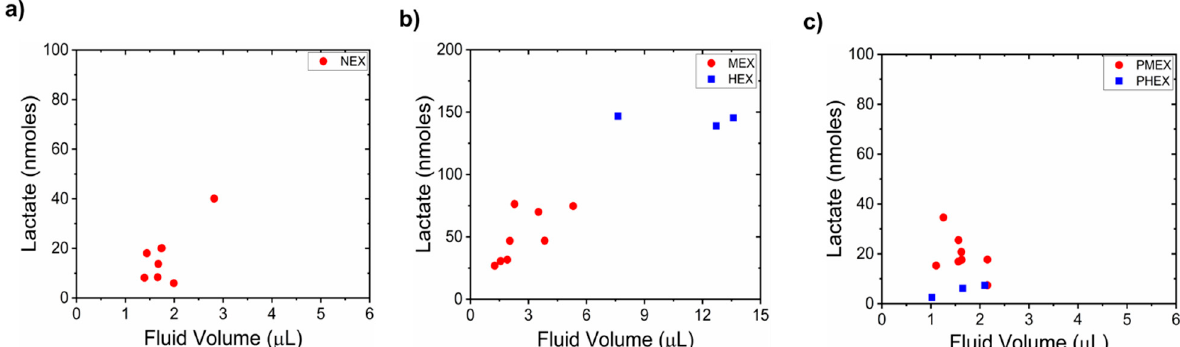
Figure 6. Relationship between sampled sweat lactate quantity (under different physiological conditions) and sweat volume on paper for a 4 M glucose hydrogel patch. Plots showing how sweat lactate depends on sweat volume during ( a ) NEX trial, ( b ) MEX and HEX trials, and ( c ) PMEX and PHEX trials. Each dot denotes data from one subject.